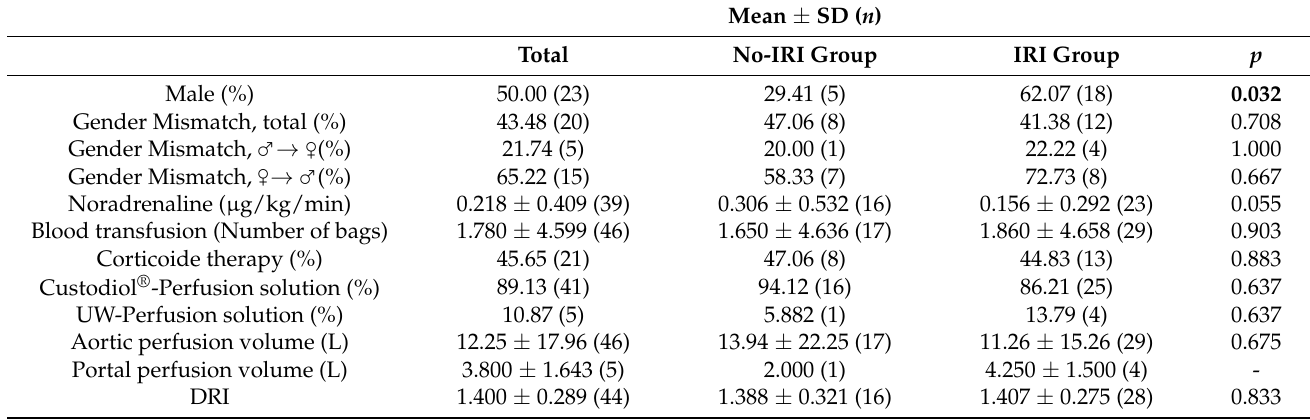
Table 2. Donor characteristics: comparison of donor criteria regarding recipients with existing or absent histo-pathological IRI. Number of patients is in round brackets. Mean with range and number of patients is in parentheses. Abbreviations: SD, standard deviation; UW, University of Wisconsin; and DRI, donor risk index. Missing data: DRI data were missing for 2 patients.